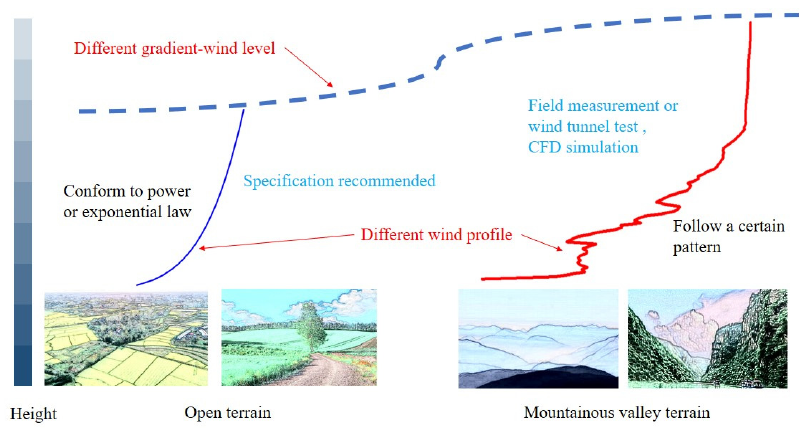
Figure 1. Difference in wind speed between open and mountainous valley terrain.